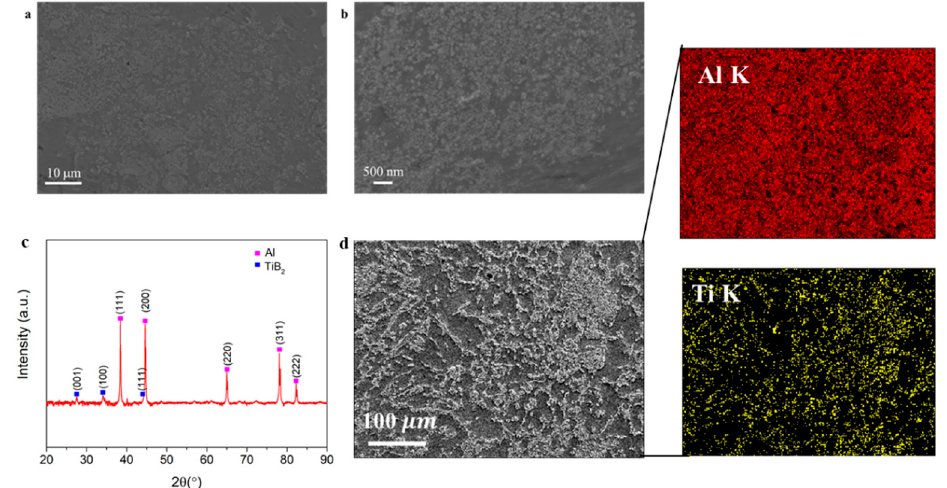
Figure 4. Electron microscopy study. ( a ) SEM images of the Al–TiB 2 nanocomposite samples. ( b ) Higher-magnification SEM images obtained from the Al–TiB 2 nanocomposites. ( c ) XRD scanning results to confirm the phases in Al–TiB 2 (Al–3 vol.% TiB 2 as an example). ( d ) EDS mapping for